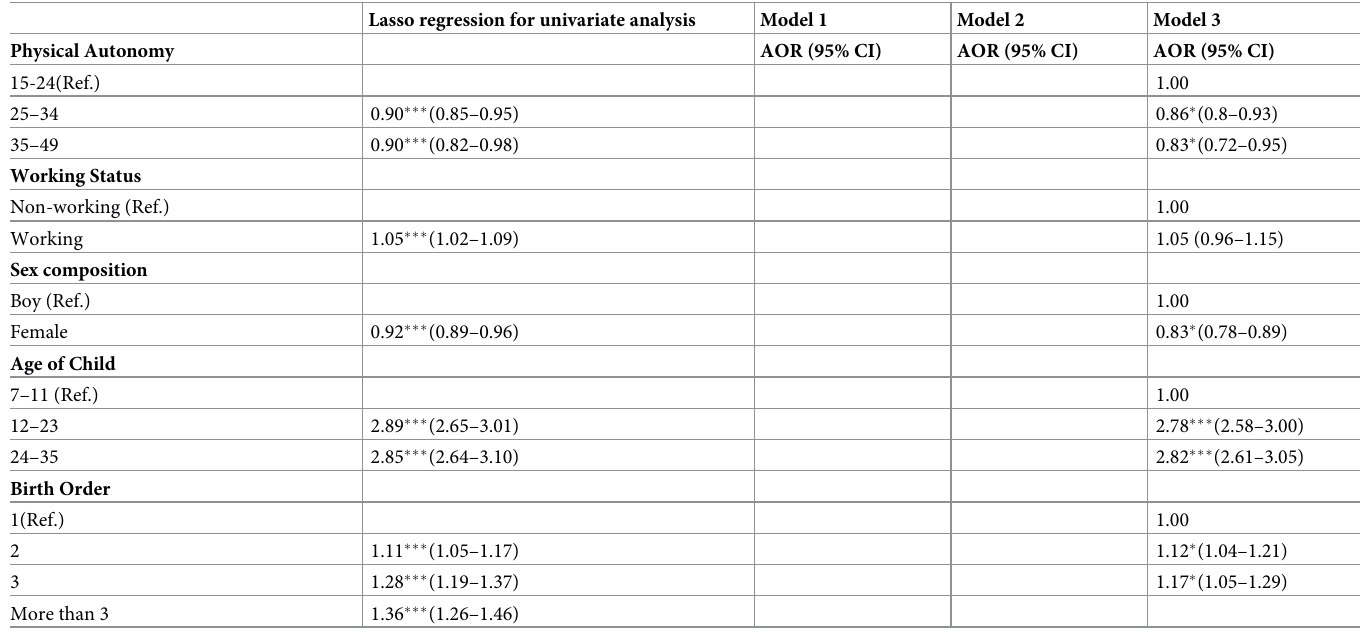
controlling for all significant household characteristics and maternal autonomy. Among the maternal autonomy variables, only financial autonomy was found to be significant. When a mother had financial autonomy, then children were 0.87 times less likely to be stunted than those with no autonomy [95% (CI-0.82, 0.94)]. The children belonging to the Muslim religion were more likely to be stunted than Hindu children [(AOR = 1.21, 95% CI-(1.11,1.32)]. Those belonging to the ST category were 0.85 times less likely to be stunted (95% CI- 0.76–0.95)) than those belonging to SC category. The children belonging to Central (AOR = 1.37, 95% CI- (1.24,1.50)), and Western [AOR = 1.27, 95% CI-(1.11,1.44)] part of India, were more likely to